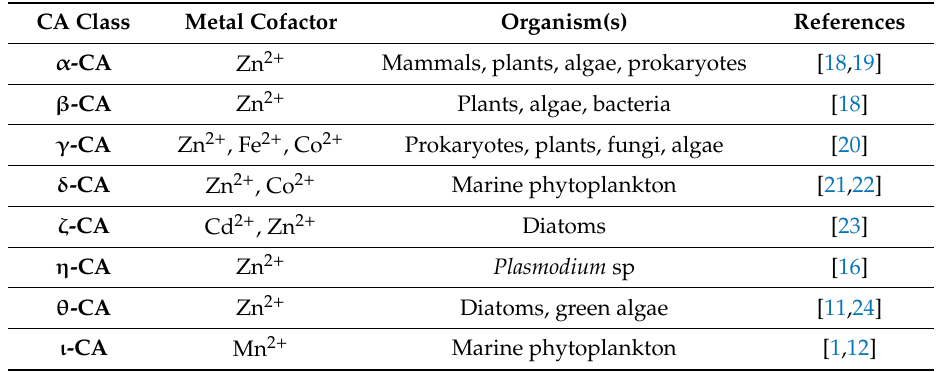
Table 1. The di ff erent carbonic anhydrases (CA) classes, their metal cofactors, and